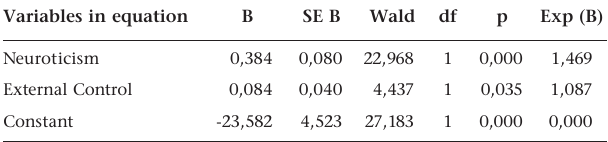
T able 10 l ogisTic regression : variables in